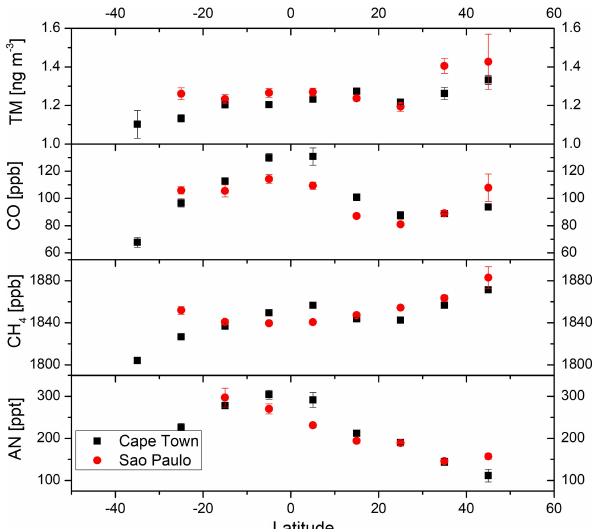
Figure 3. Latitudinal distributions of tropospheric TM, CO, CH 4 and acetonitrile (AN) in winter (December, January and February, DJF) during the flights from Cape Town and São Paulo to Munich. The points represent averages and the vertical bars their standard error. No acetonitrile data are available south of 30 and 20 ◦ S for flights to Cape Town and São Paulo,